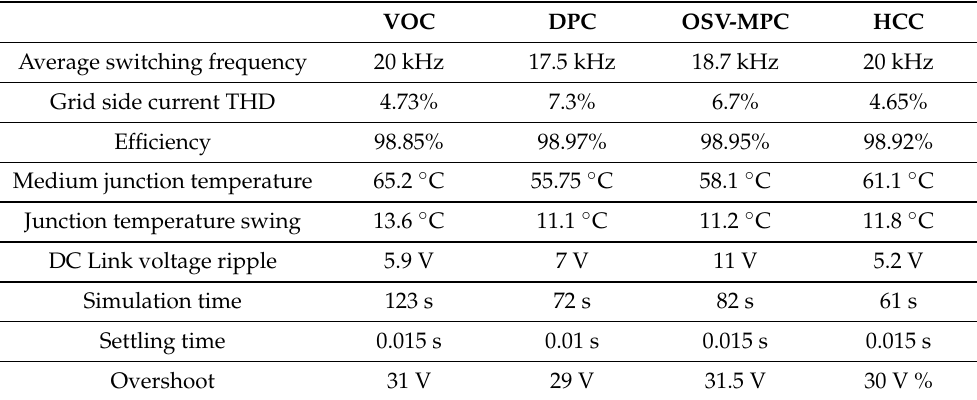
Table 5. Comparison of simulation results for different AFE control techniques.